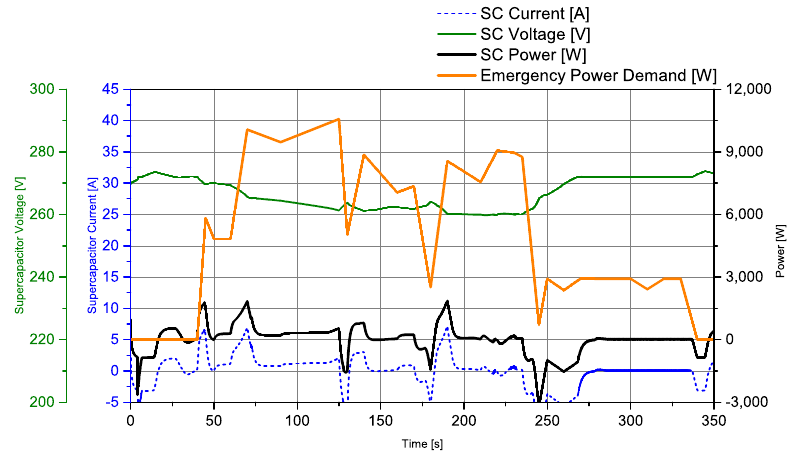
Figure 14. Current and voltage change of the supercapacitor during simulation.